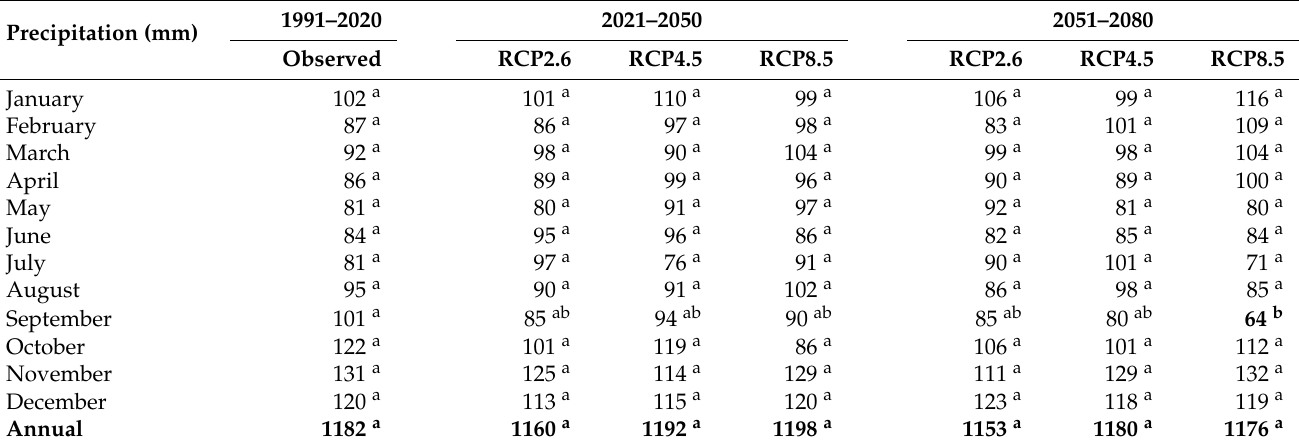
Table 5. Average precipitations (mm) observed in the eastern zone (Alliston) during the 2000s and expected in normal years (PoE = 50%) under different projections during the 2030s and